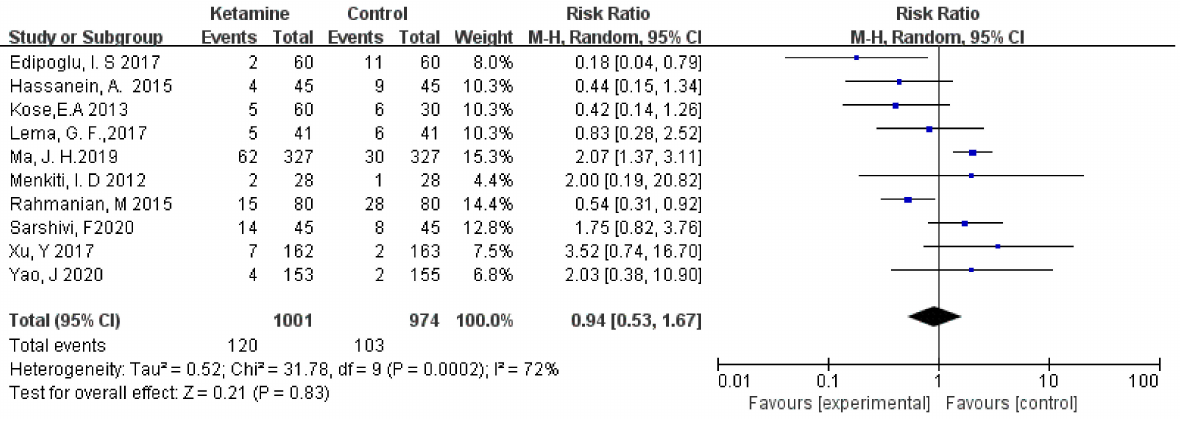
Figure 5. Forest plot of vomiting